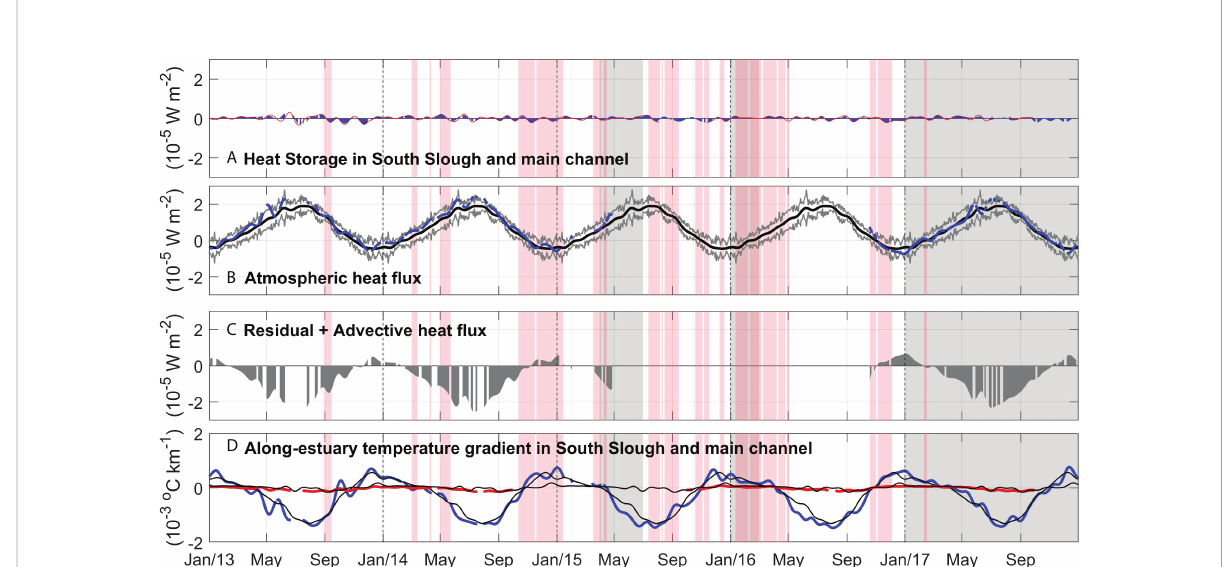
FIGURE 8 Heat budget components in the Coos Estuary during 2013-2017. (A) Heat storage in South Slough (blue) and the main channel (red). (B) Atmospheric heat fl ux using data from the Valino water quality station. (C) Residual + Advective heat fl ux (Heat storage minus Atmospheric heat fl ux), and (D) Along-estuary temperature gradient in South Slough (Charleston to Winchester) in blue and in the main channel (Charleston to KoKwel Wharf) in red. Positive ∂ T av / ∂ x indicates that the station closest to the ocean is warmer than the station furthest up-estuary. Red bands show periods in which water temperature at Charleston WQ is above the 2004-2014 climatology +1 standard deviation (Figure 6). Gray bands show periods in which eelgrass density at Valino is below the 2004-2014 climatology by one standard